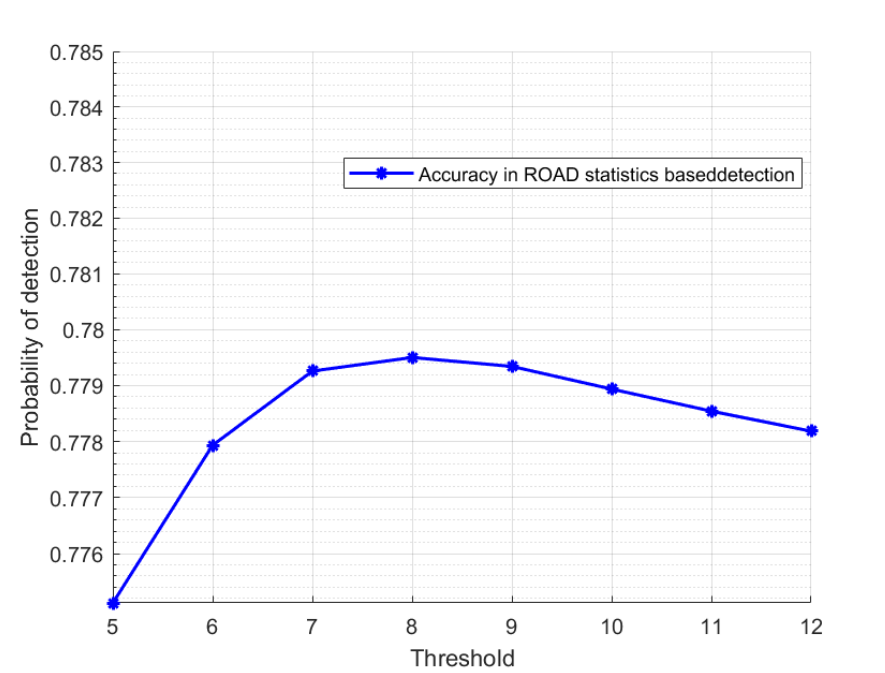
Figure 21. Accuracy in ROAD statistics-based detection (SNR = 5 dB) vs. threshold.